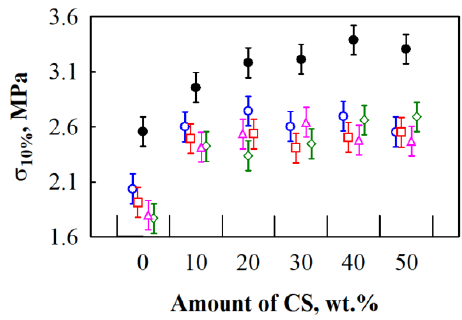
Figure 4. Impact of various amounts of corn starch (CS) binder and different hemp shiv (HS) fractions on compressive stress of BcB: ○ — 5/10 mm; □— 10/20 mm; ◊— 2.5/20 mm; ∆— 2.5/5 mm; ●— shredded HS.